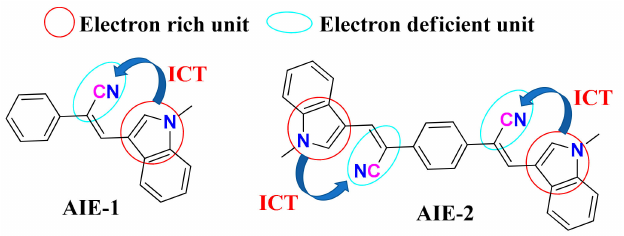
Figure 1. Structure of AIE-1 and AIE-2. ICT is abbreviated for intramolecular charge transfer